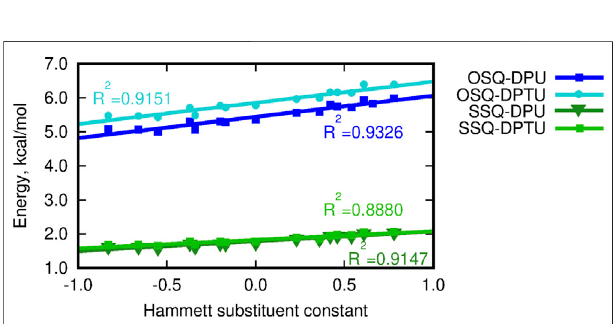
FIGURE 6 | Hydrogen bond energy estimated according to Espinosa et al. (1998) versus the Hammett substituent constant.